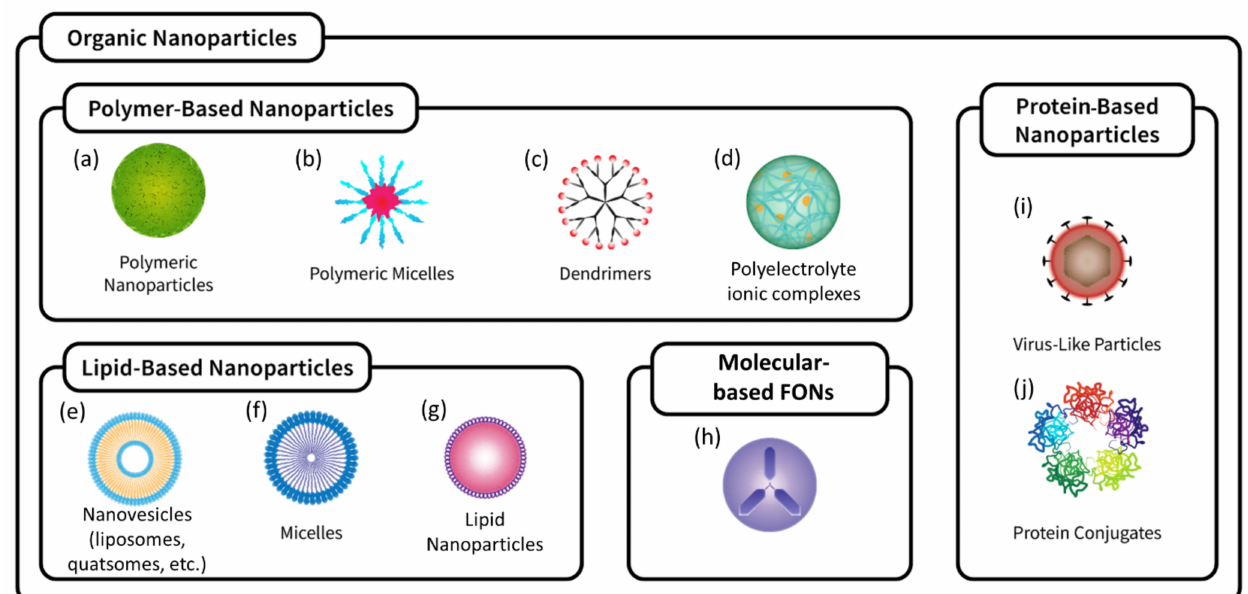
Figure 1. Schematic representation of common organic nanoparticles classified with respect to their composition: polymer-based nanoparticles (( a ) polymeric nanoparticles, ( b ) polymeric micelles, ( c ) dendrimers, ( d ) polyelectrolyte ionic complexes); lipid-based nanoparticles (( e ) nanovesicles, ( f ) micelles, ( g ) lipid nanoparticles); molecular-based FONs ( h ); protein-based nanoparticles (( i ) virus-like particles, ( j ) protein